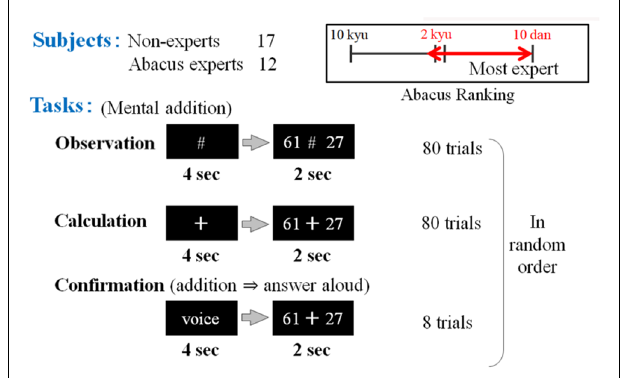
FIGURE 1 | The first experimental paradigm. The participants (17 non-experts and 12 abacus experts) were instructed to perform or confirm at least a mental addition of 2 digits plus 2 digits’ number, immediately after numbers were presented (e.g., 61 + 27). Participants (novices and experts in using a Soroban) were asked to perform three tasks: observation, calculation, and confirmation.